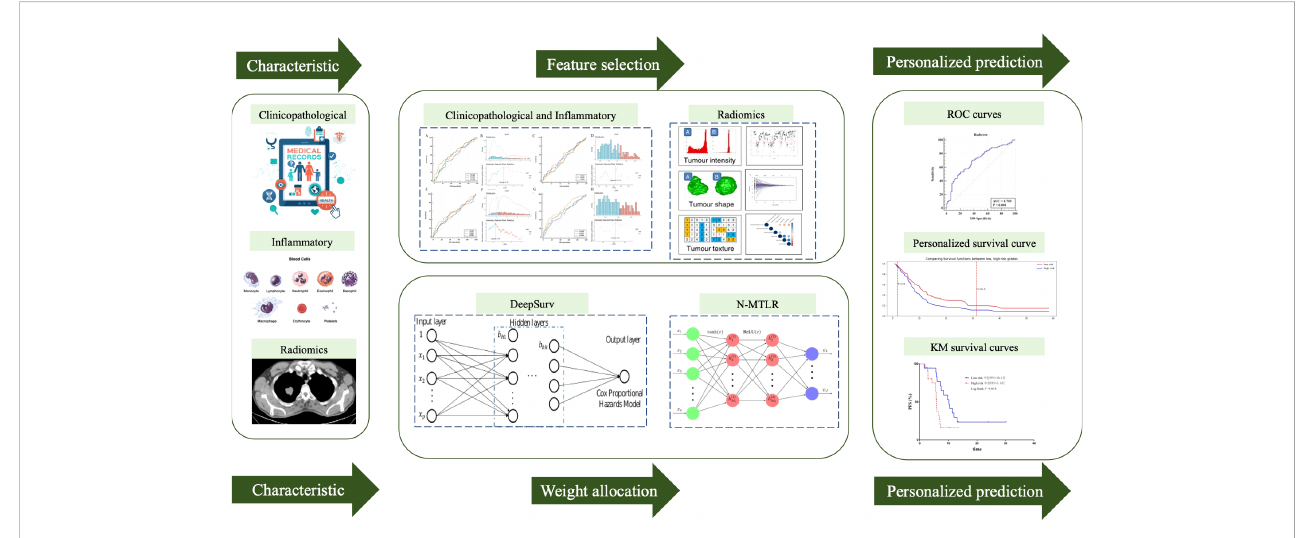
FIGURE 1 Graphic fl ow chart of development of prognostic